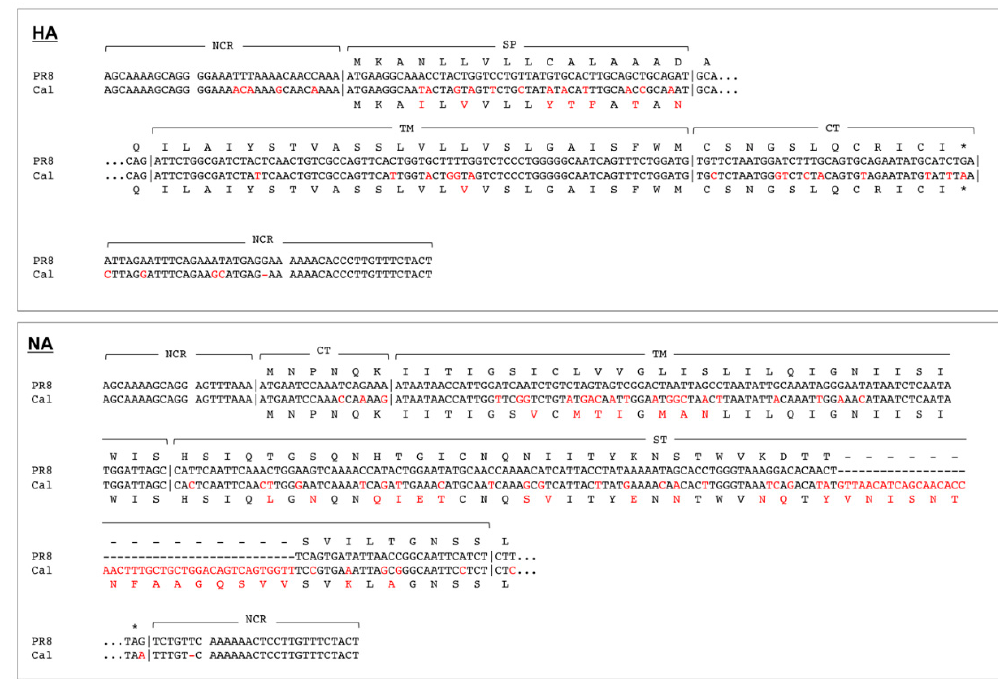
Figure 3. Alignments of nucleotide and amino acid sequences of HA and NA between PR8 and Cal. For HA vRNAs, the 3 ′ -NCR-signal peptide region and the TM-CT-5 ′ -NCR region are shown. For NA vRNAs, the 3 ′ -NCR-CT-TM-ST region and the 5 ′ -NCR region are shown. Nucleotides and amino acids that differ between the two strains are shown in red. Deletion of nucleotides and amino acids is shown with a dash. NCR—non-coding region; SP—signal peptide; TM—transmembrane; CT—cytoplasmic tail.